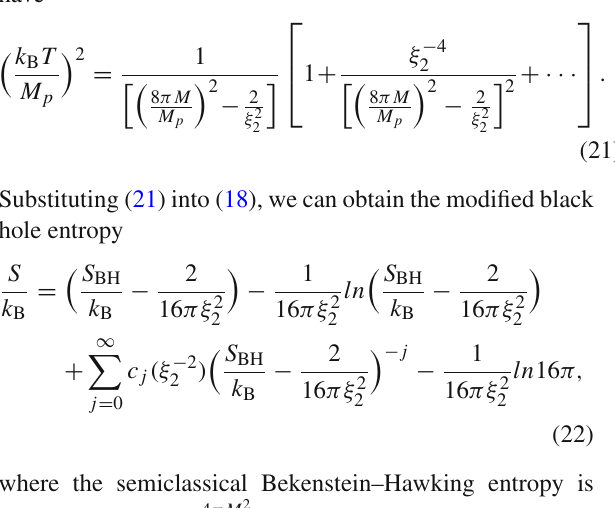
Fig. 4 The LIV-DR induced remnant entropy versus ξ